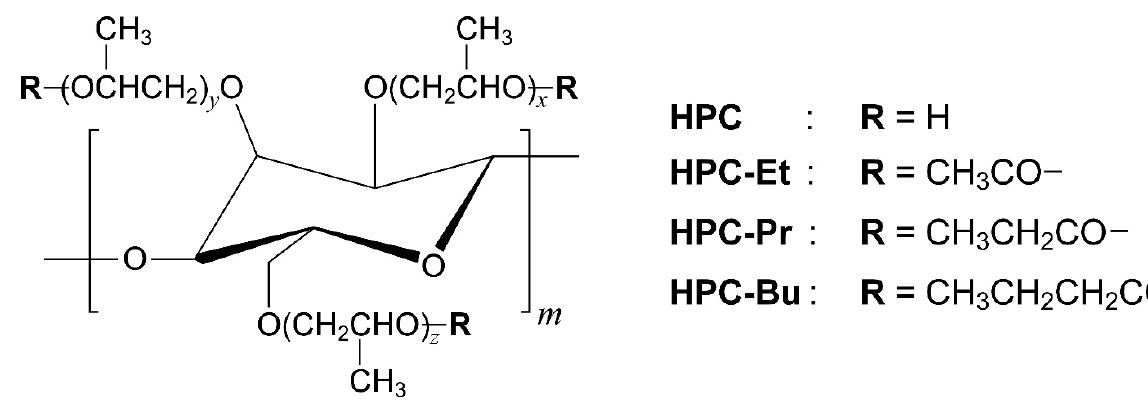
Figure 1. Chemical structures of HPC and its derivatives possessing alkanoyl side chains. The terminal hydroxy groups of pristine HPC were fully substituted with acetyl (ethanoyl), propionyl, or butyryl groups. All HPC derivatives of HPC-Et, HPC-Pr, and HPC-Bu showed thermotropic CLC phase with visible reflection as heating above ~110, ~95, and ~60 °C, respectively.